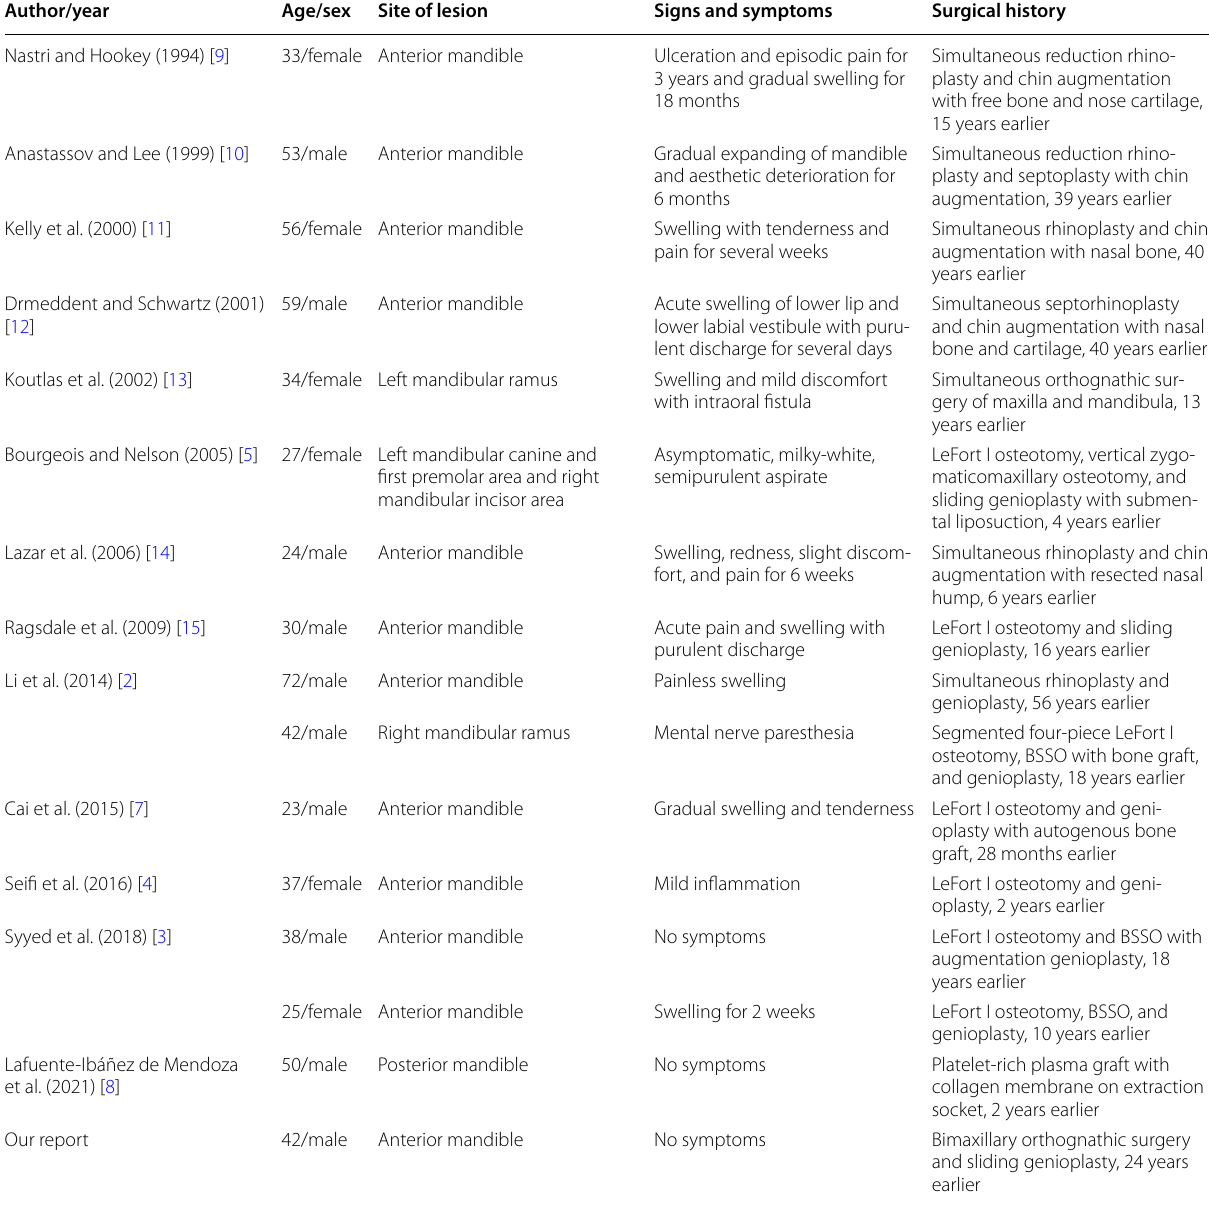
BSSO Bilateral sagittal split